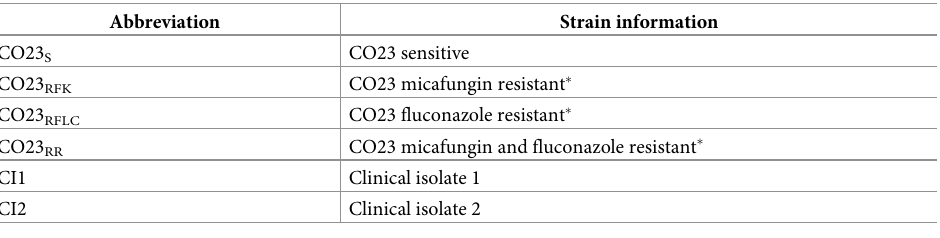
antimicrobial activity of fluconazole (FLC) and micafungin (FK) and results are reported in Table 3. MIC values obtained for CO23 , CO23 and CO23 strains were in agreement S RFK RFLC with those previously reported [18]. MIC values obtained for CO23 strain confirmed the RR double resistance of this strain for both FLC and FK drugs, yielding values of 32 μ g/mL for FLC and 8 μ g/mL for FK. Analyses of both clinical isolates 1(CI1) and 2 (CI2) showed a double resistance for FLC and FK with MIC values of CI1 overlapping those of the CO23 strain. On RR the contrary, in CI2, an halved MIC value of 16 μ g/mL for FLC was obtained compared with CO23 strain, while the same MIC value of 8 μ g/mL for FK was observed. RR Table 2. Analyzed